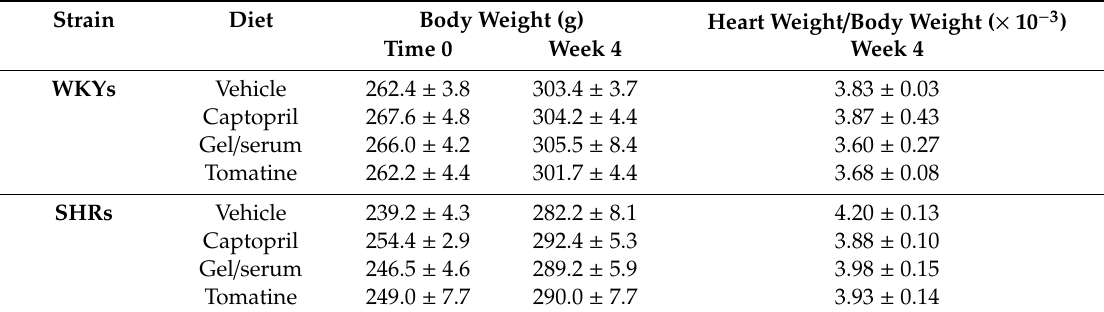
Table 3. E ff ects of di ff erent treatments on body weight and heart weight to body weight ratio in SHRs and